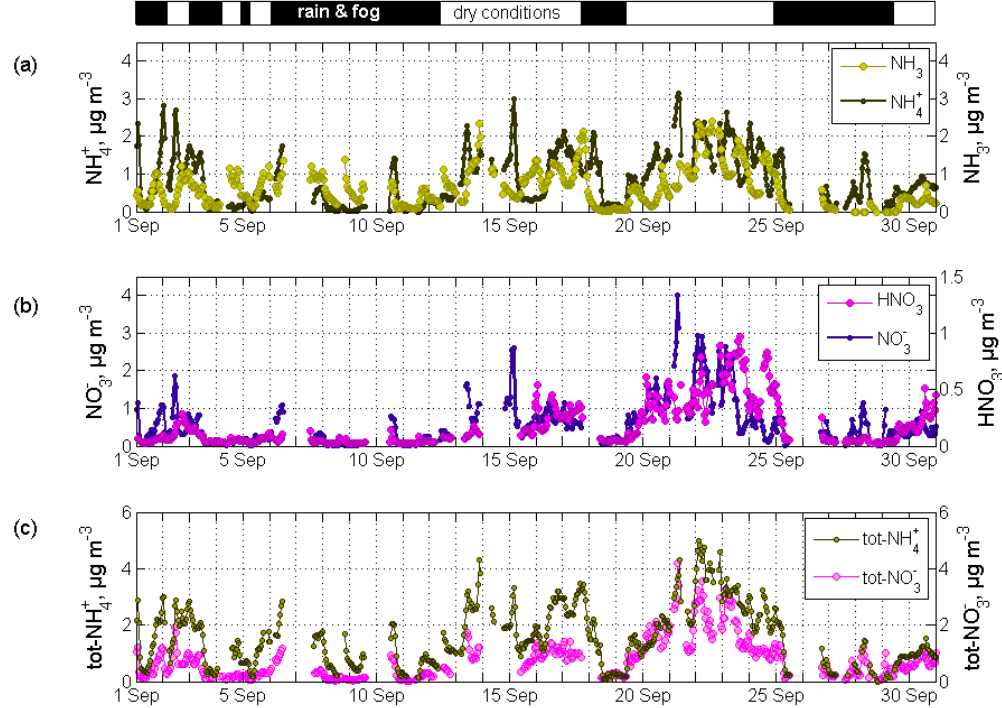
Fig. 2. Diel variations of (a) NH 3 and particulate NH + in terms of N) measured in September 2007 at 30.9m (above ground) at the Weidenbrunnen site. Indicated by the black and white bar are episodes of rain and fog and dry periods, respectively (cf. Fig. 1).